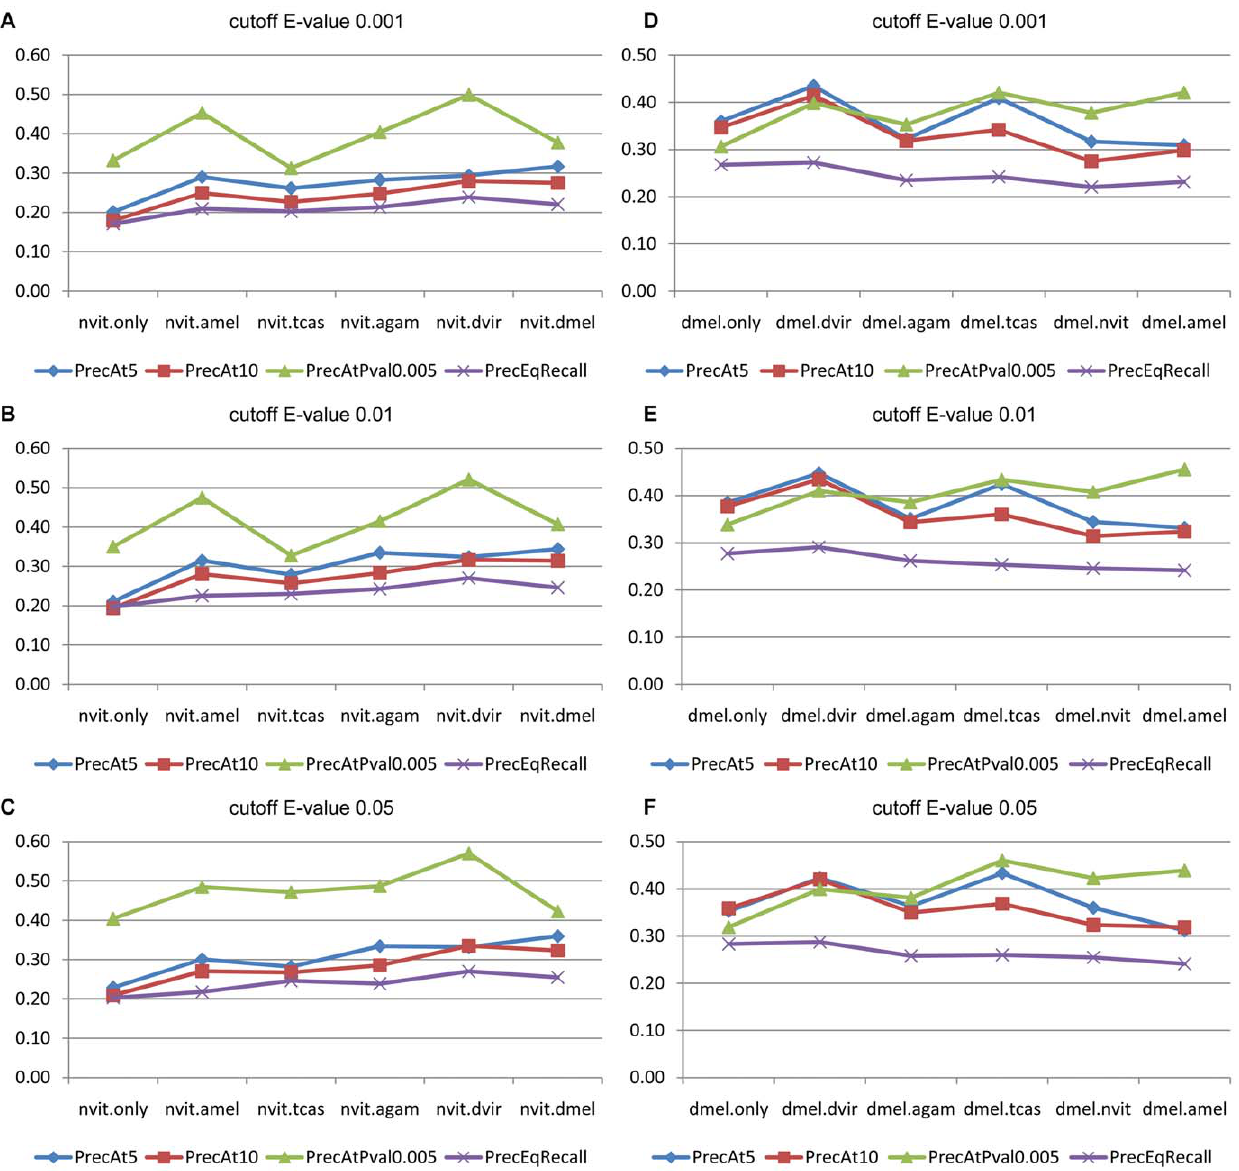
Figure 4. Performance of predicted motif – GO associations using cross-species comparison, evaluated based on ChIP-based binding data. The prediction performance is shown as the precision of the top 5 and top 10 predictions per motif (‘‘PrecAt5’’ and ‘‘PrecAt10’’, respectively), the precision at a significance threshold (p-value) of 0.005 (‘‘PrecAtPval0.005’’), and as the point where precision equals recall (‘‘PrecEqRecall’’). Three different levels of significance (‘‘cutoff E-value’’ 0.001 (A, D), 0.01 (B, E), and 0.05 (C, F)) were used to define the set of true associations, and the effect of cross-species comparison on the Nasonia (A–C) and Drosophila (D–F) motif function maps were reported separately.